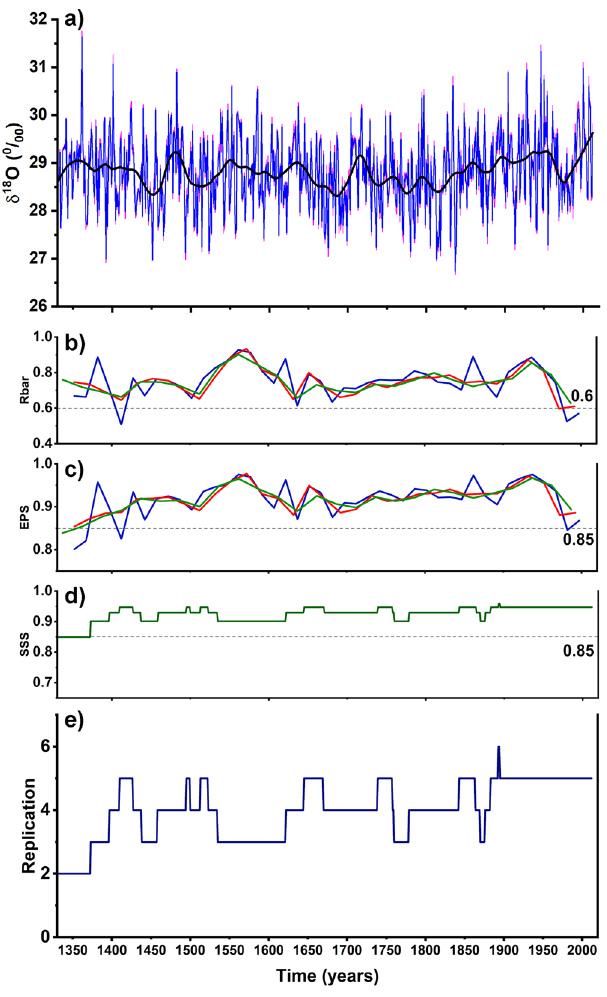
Fig. 3 Raw δ 18 O values and the corresponding statistics. a The raw δ 18 O values measured in the Pinus cembra L . from C ă limani Mountains, Romania (blue line), 31-year running mean (black line), and 95% calculated con fi dence level of the raw δ 18 O values (pink line). b The inter-series correlation (Rbar) values calculated for the raw δ 18 O series with different running window: 50 years with an overlap of 25 years (green line), 40 years with 20 years overlap (red line), and 30 years with 15 years overlap (blue line). c The Expressed Population Signal (EPS) calculated with different running window: 50 years with an overlap of 25 years (green line), 40 years with 20 years overlap (red line), and 30 years with 15 years overlap (blue line). d Subsample Signal Strength (SSS) for the raw δ 18 O series (green line). e Replication (dark blue line). The gray bars represent time periods for which the replication is ≤